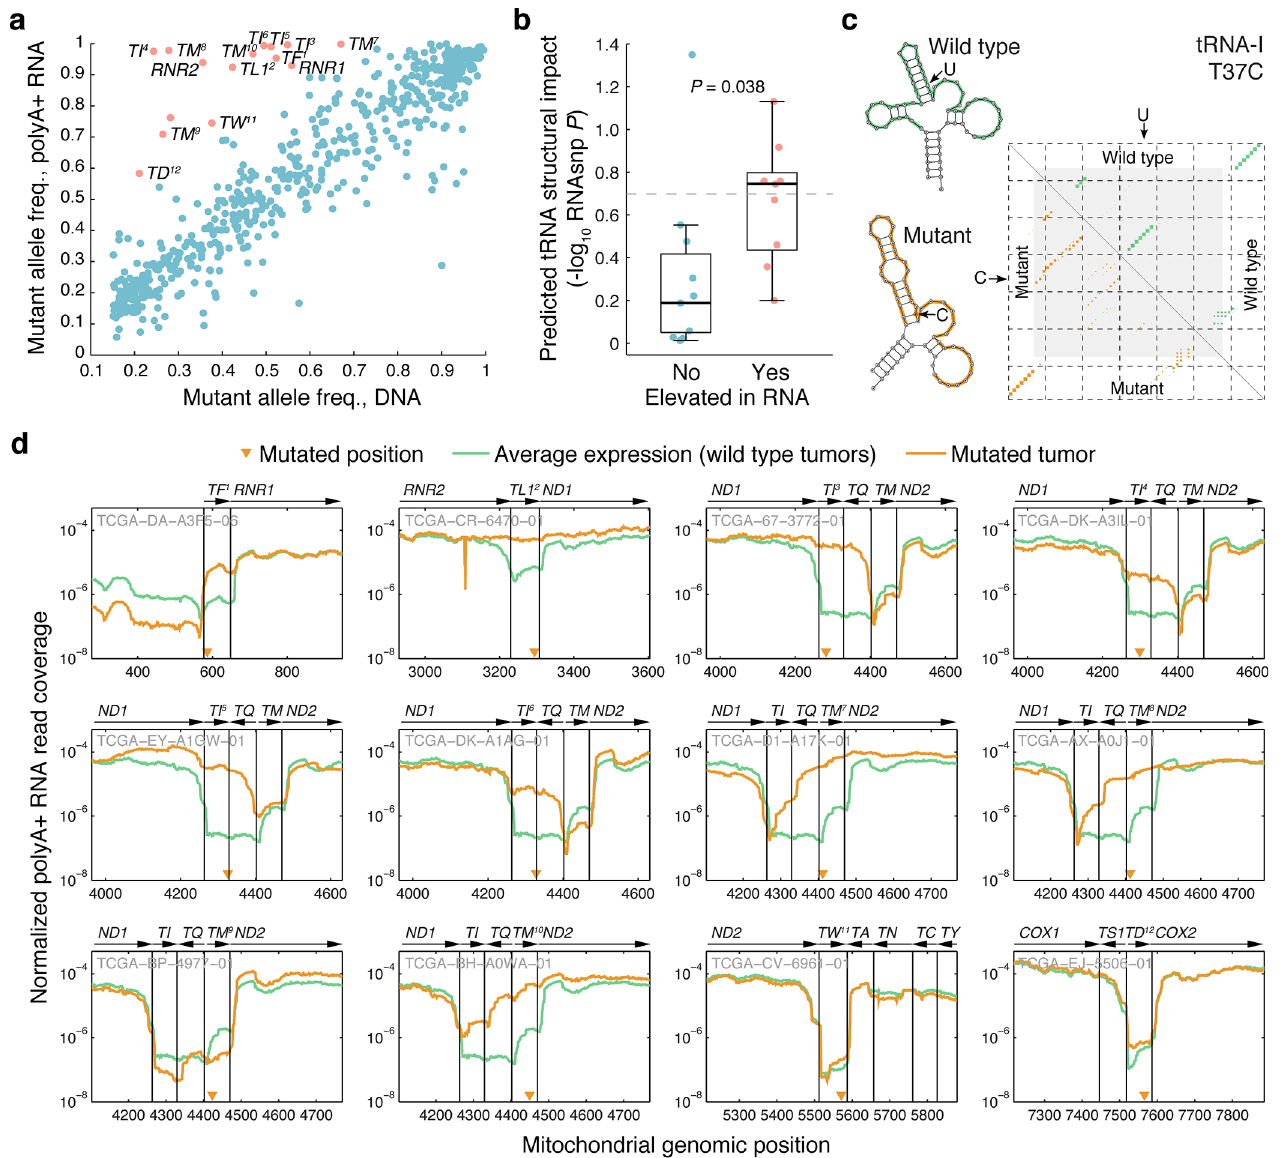
Fig 4. Comparison of allelic ratios in DNA and RNA reveals allelic imbalances consistent with impaired tRNA processing. ( a ) Scatter plot of allele frequencies (heteroplasmy levels) in DNA vs. RNA for all 616 mutations ( r = 0.91). 15 mutations with marked accumulation in polyA+ RNA relative to DNA (frequency difference > 0.3) are indicated in red. 12 of these 15 mutations were in tRNAs regions (numbered 1 – 12 in superscript), indicative of impaired processing of the polyA+ precursor RNA to a mature polyA- tRNA. ( b ) tRNA mutations accumulated in polyA+ RNA (red in panel a) showed elevated predicted RNA structural impact, determined using the RNAsnp tool [35,36], compared to other tRNA mutations ( P = 0.038, Wilcoxon rank sum test). The comparison was based on 9 and 9 inhibiting/non-inhibiting mutations (cases where the wild-type sequence failed to fold into a tRNA-like structure were excluded). The dotted line indicates an RNAsnp P -value (structural impact score) of 0.2 ( c ) Example RNAsnp result for a U to C mutation in position 37 of the mitochondrial isoleucine tRNA. The dot-plot shows the ensemble base-pair probabilities of the wild type (upper triangle) and mutant (lower triangle) sequences, with the altered local region indicated in gray. Wild type and mutant minimum free energy structures are shown (altered local region in color). ( d ) Normalized RNA read coverage, showing relative (per-tumor normalized) polyA+ expression levels across the mitochondrial genome in mutated tRNA regions for the 12 tRNA mutations indicated in panel a (each identifiable by a superscript number). Mutated cases (yellow) are compared to controls (green, median of all non-mutated cases). Gene strand orientation is indicated by arrows (right-facing: L-strand). Mutated positions are indicated by triangles. Samples IDs are shown in gray. tRNA genes are referred to as “ TX ” , where X = the single letter amino acid